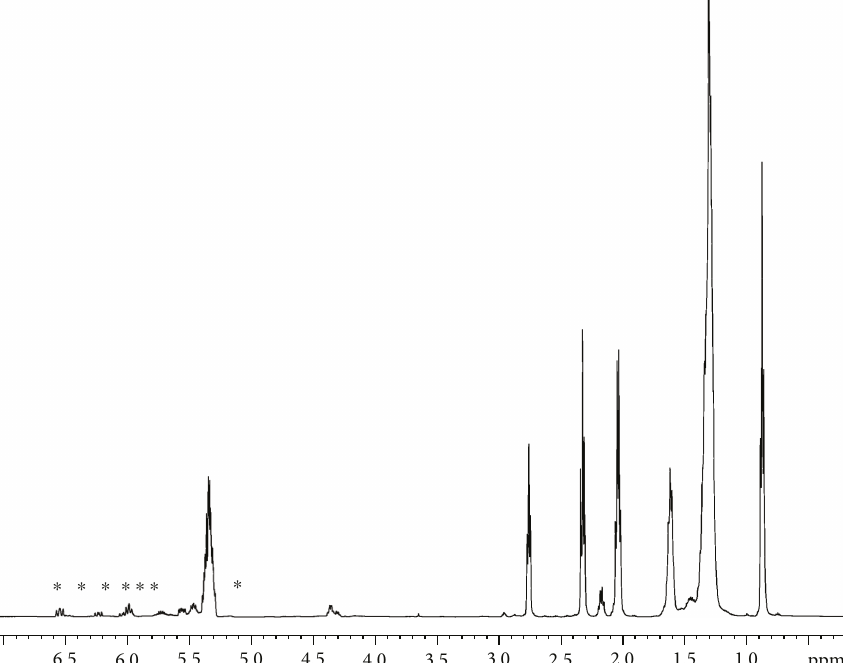
Figure 4: 1 H NMR spectrum of sample C-1 at a higher magni fi cation. The peaks marked with asterisks correspond to the oxidized conjugated diene structure.